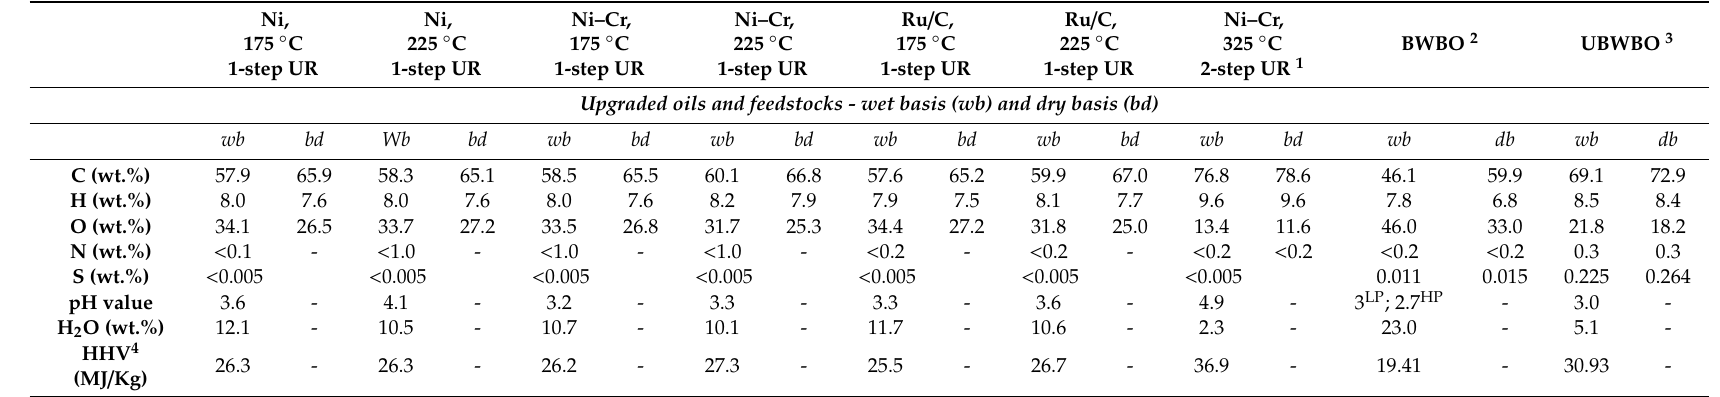
Table 1. Chemical composition of upgraded oils at di ff erent reaction